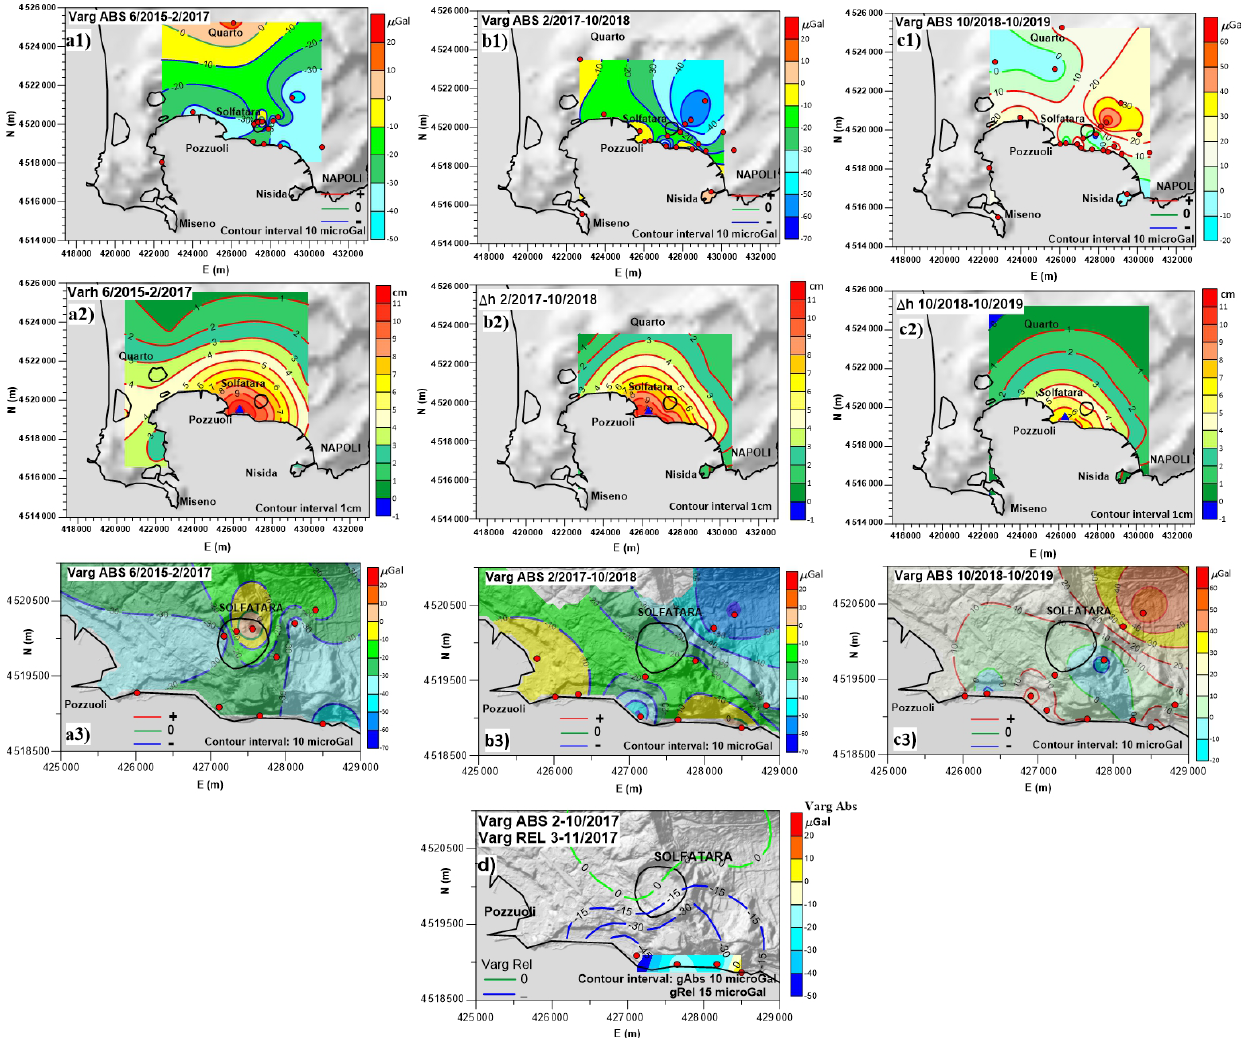
Figure 2. Areal pattern of the absolute gravity changes from June 2015 to October 2019, represented with a contour interval of 10µGal considering the uncertainties on measures. In each column are respectively shown (from the top to the bottom) the absolute gravity changes, the height changes (see text for details) and a zoom of the gravity changes over the Pozzuoli East coastline-Solfatara-Pisciarelli-Astroni area. Columns (a) , (b) and (c) respectively refer to changes over the June 2015–February 2017, February 2017–October 2018 and October 2018– October 2019 time intervals. The red full points in (a1) , (b1) , (c1) and (a3) , (b3) , (c3) indicate the absolute gravity stations used for plotting; the blue full triangle in (a2) , (b2) , (c2) represents the RITE permanent GPS station. At the bottom of the figure, in (d) , the areal pattern of the February–October 2017 absolute gravity changes (filled field) at four stations (red full points) along the east coastline of Pozzuoli is shown. In it the space distribution of relative gravity changes in the period March–November 2017 is also represented for comparison; the blue and green contour lines respectively indicate negative and null gravity